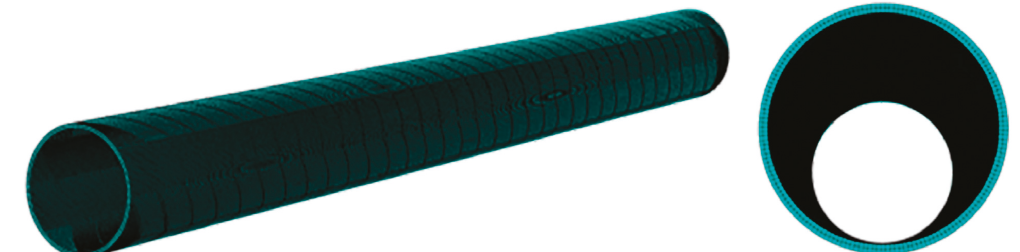
Figure 3: Grid diagram of the finite element model of the straight pipe section.